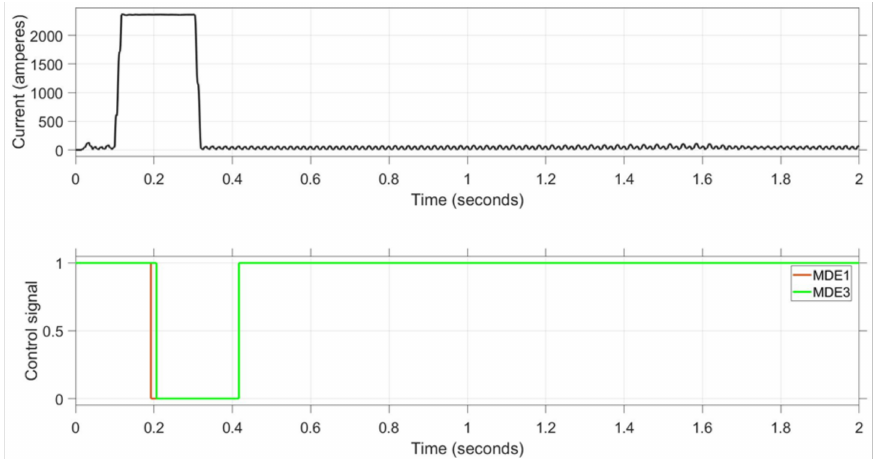
Figure 10. Recloser response for MDE1 and MDE3 in case